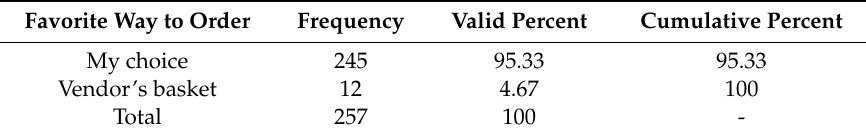
Table 6. The frequency of the selection method for products (N =